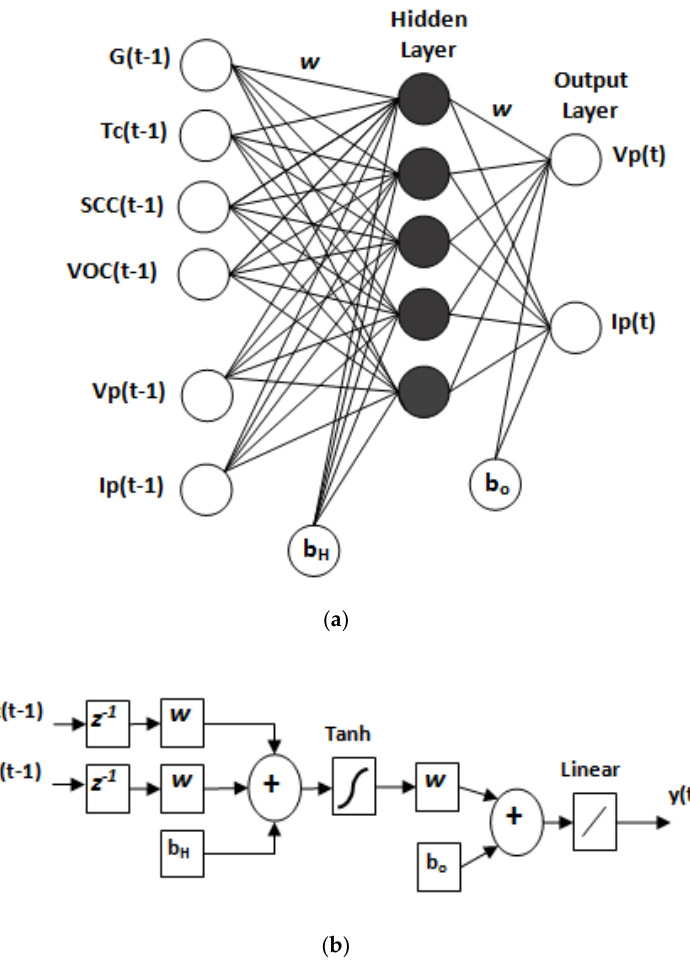
Figure 8. The developed NARX network. ( a ) The architecture network topology and ( b ) mathematical model. G is solar radiation; Tc is panel temperature; SCC is short circuit current; OCV is open-circuit voltage; b H is the bias for hidden layer; b O is the bias for output layer; x(t − 1) is NARX exterior data at time t-1; y(t − 1) is NARX past output values. Table 1. The manufacturer specifications of the photovoltaic (PV) panels.